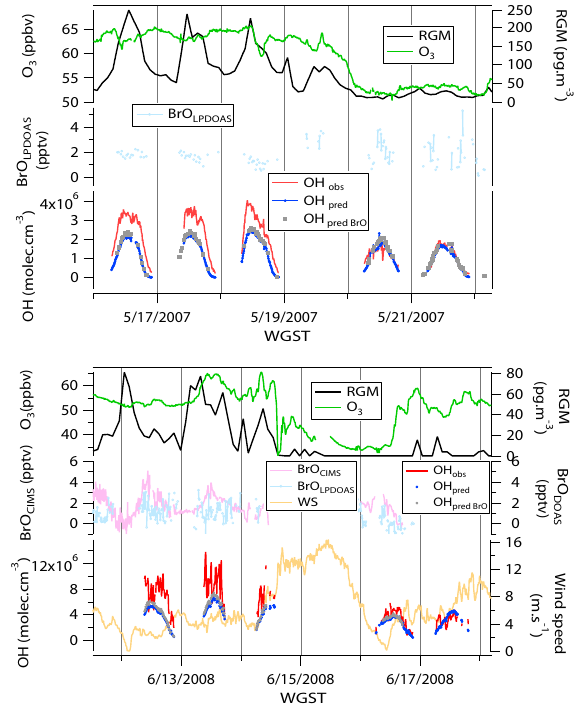
Fig. 9. (a) : Observations of RGM, O 3 , BrO by DOAS and OH, and predictions of OH from the BM and BM BrO when enhanced RGM were observed in 2007 (16 May–21 May 2007); (b) : The observations of RGM, O 3 , OH, wind speeds, BrO by CIMS and DOAS, and the predictions of OH from the BM and BM BrO when enhanced RGM were observed in 2008 (11 June–17 June 2008).